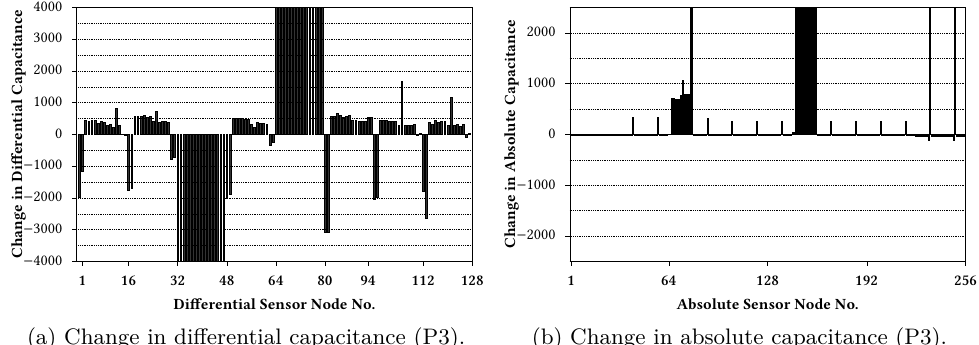
Figure 19: Attack Profile 3 (P3): attack with two holes of diameter 0 . 3 mm severing Tx5, Tx10, and